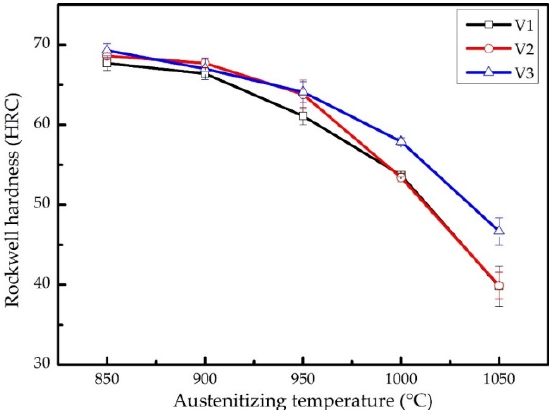
Figure 2. The macro-hardness of the samples after quenching at various